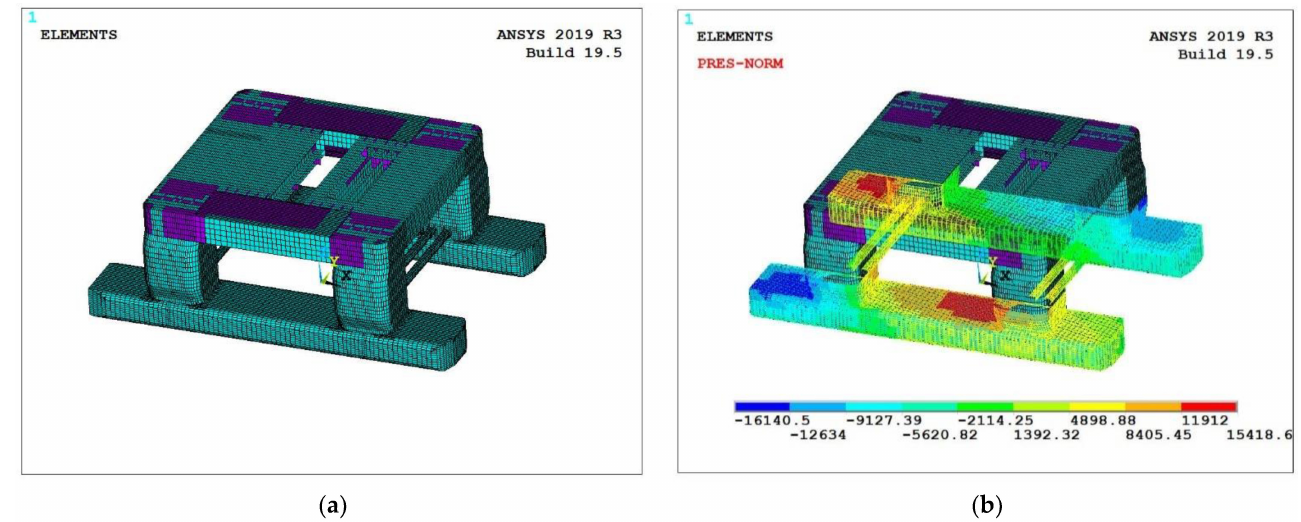
Figure 8. Nonlinear finite element model developed for the object semisubmersible platform. ( a ) a finite element model of semi submersible platform, ( b ) a finite element model of semi submersible platform under wave